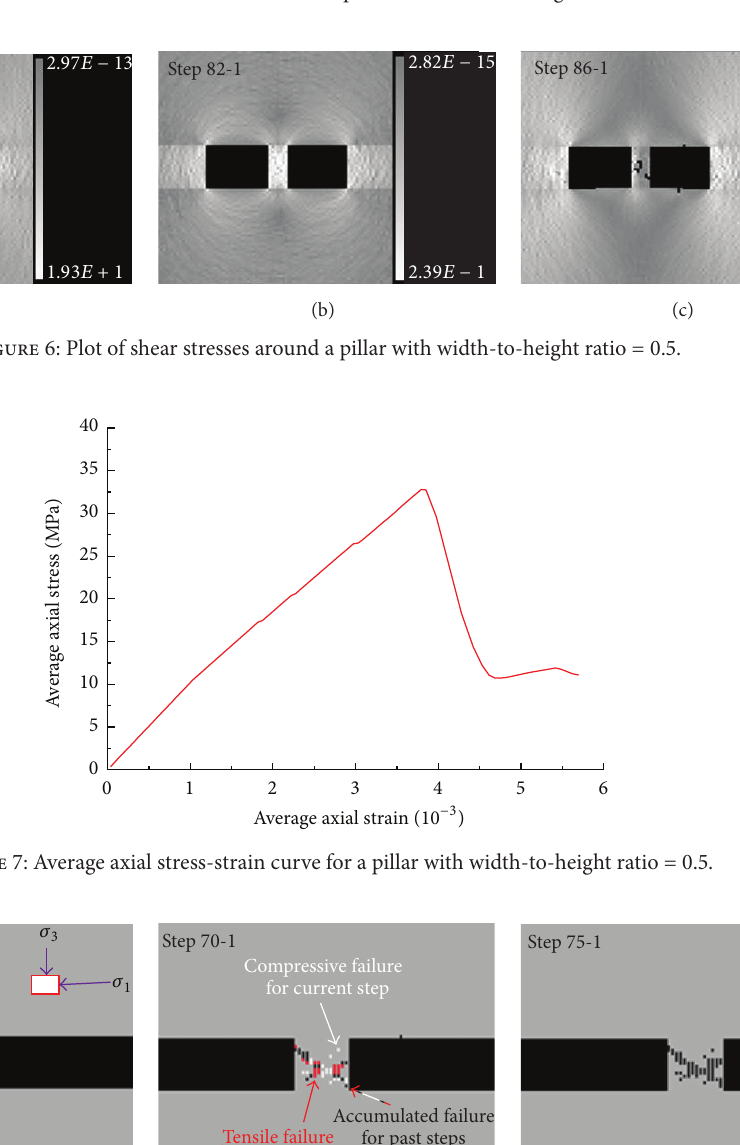
Figure 5: Plot of acoustic emissions for a pillar with width-to-height ratio = 0.5.